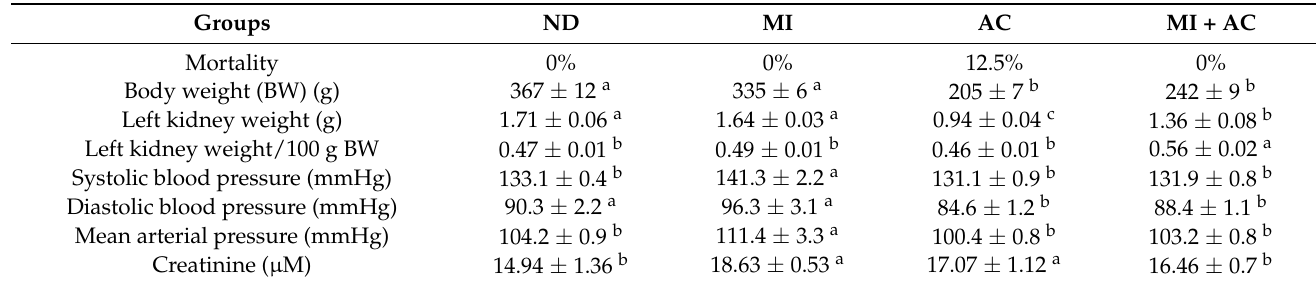
Table 1. Weight and blood pressure in 12-week-old male offspring.